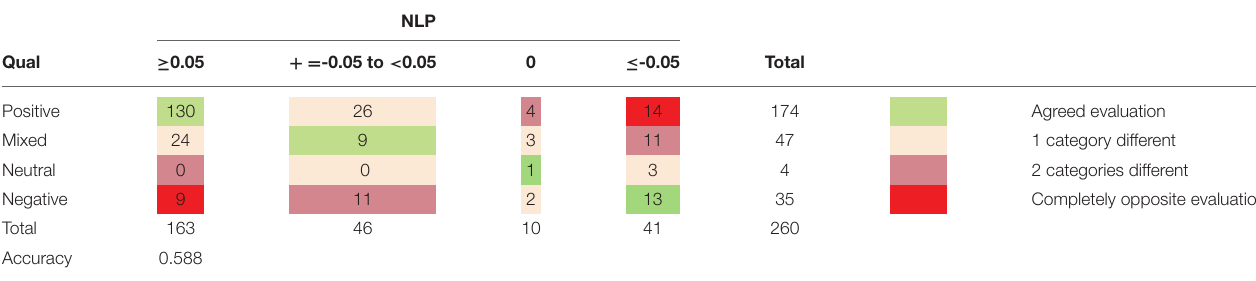
TABLE 7 | Sentiment analysis confusion matrix [ ± 0.05].